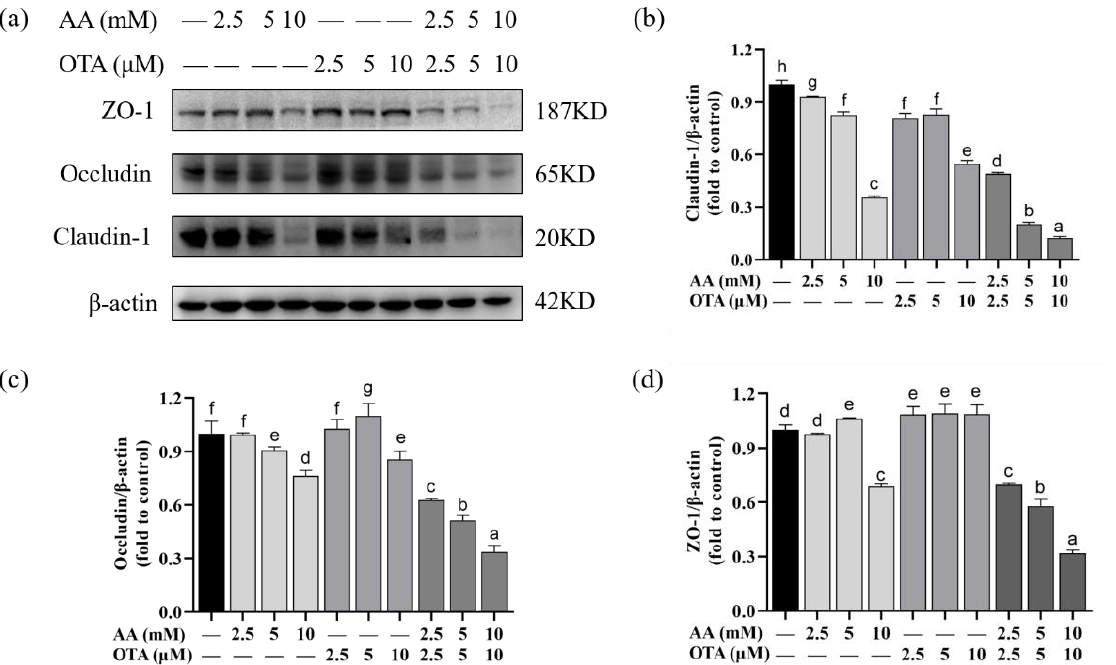
Figure 7. Effect of AA and OTA on the expression of TJ proteins in the Caco-2 cells. ( a ) TJ proteins were determined by SDS-PAGE. ( b – d ) Relative protein expression of TJ from different groups. Values are shown as means ± SEM ( n = 3). a–h Letters indicate differences between groups, p < 0.05.